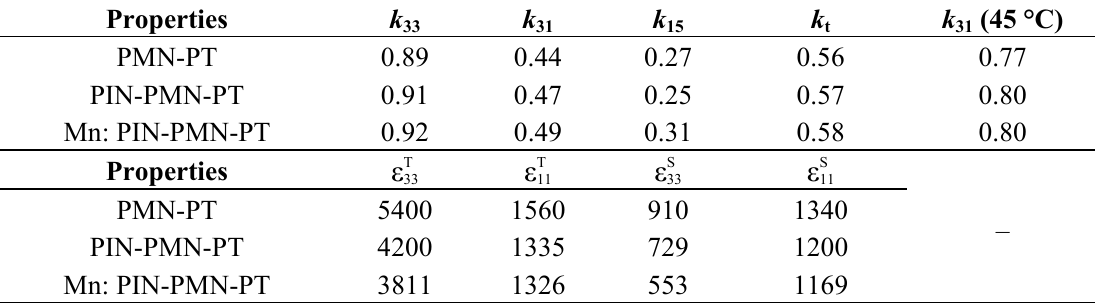
, and dielectric constants, ε ij